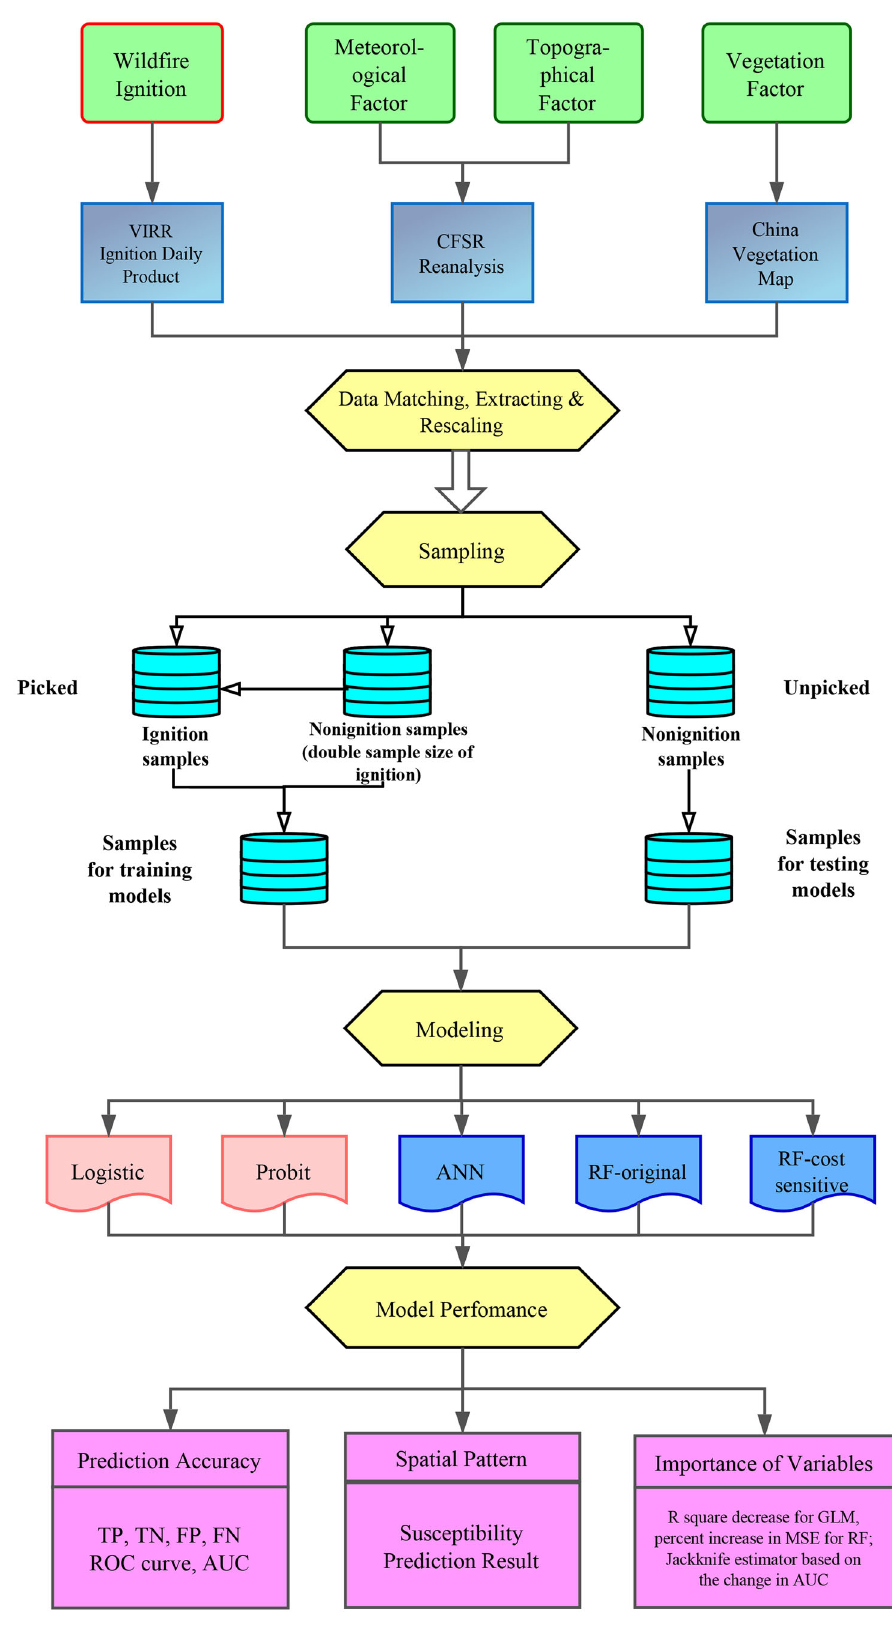
Fig. 4 Flow chart for establishing the wildfire susceptibility models. Note : TP is abbreviated for true positive, TN for true negative, FP for false positive, FN for false negative, ROC for receiver operating characteristic, AUC for area under the curve of ROC, GLM for generalized linear models (logistic and probit regression specifically in this article), MSE for mean squared error, RF for random